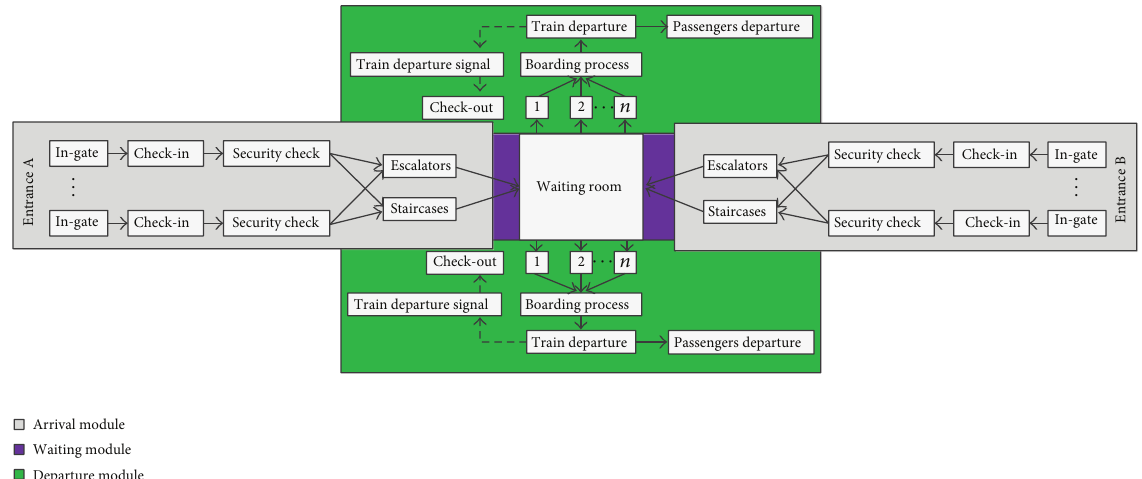
Figure 1: The operation process of different functional modules of railway passenger